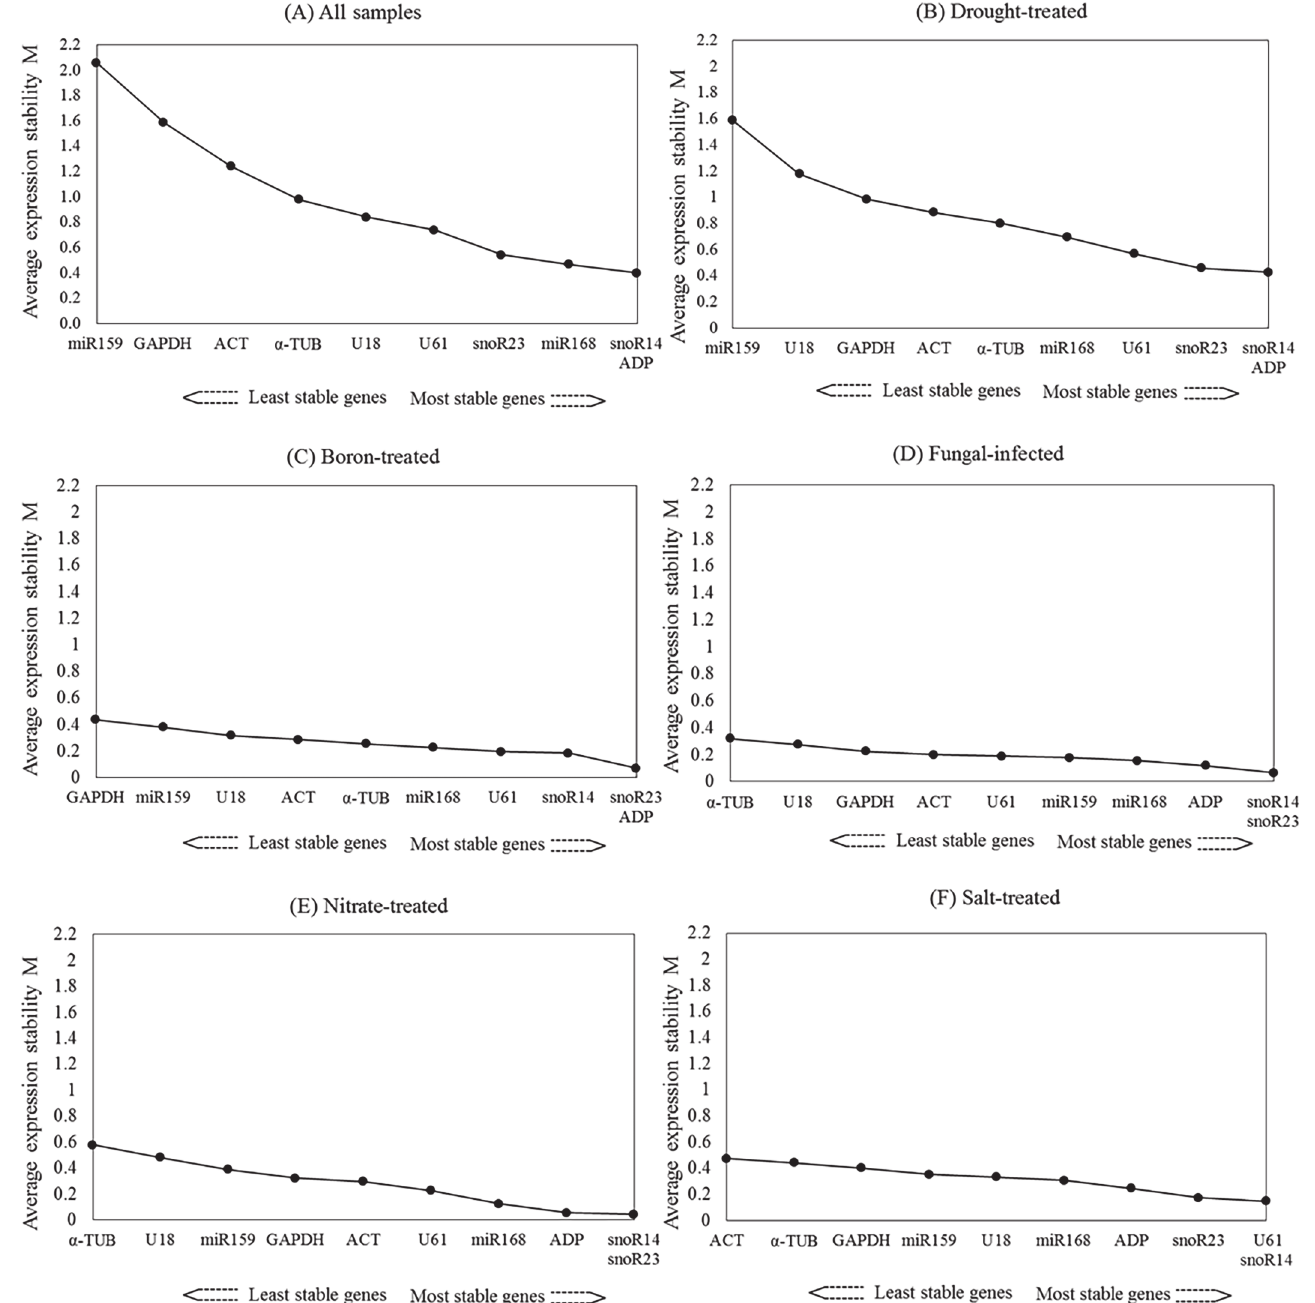
Fig 1. geNorm analysis of average expression stability values and ranking of ten candidate reference genes based on pairwise comparison. Genes on the x-axis in order of increasing stability (y-axis M value) for (A) all samples, (B) drought-treated samples, (C) boron-treated samples, (D) fungal-infected samples, (E) salt-treated samples and (F) nitrate-treated samples. Under individual treatment condition, reference genes ’ expression stability was obtained comparing to the untreated (control) condition.